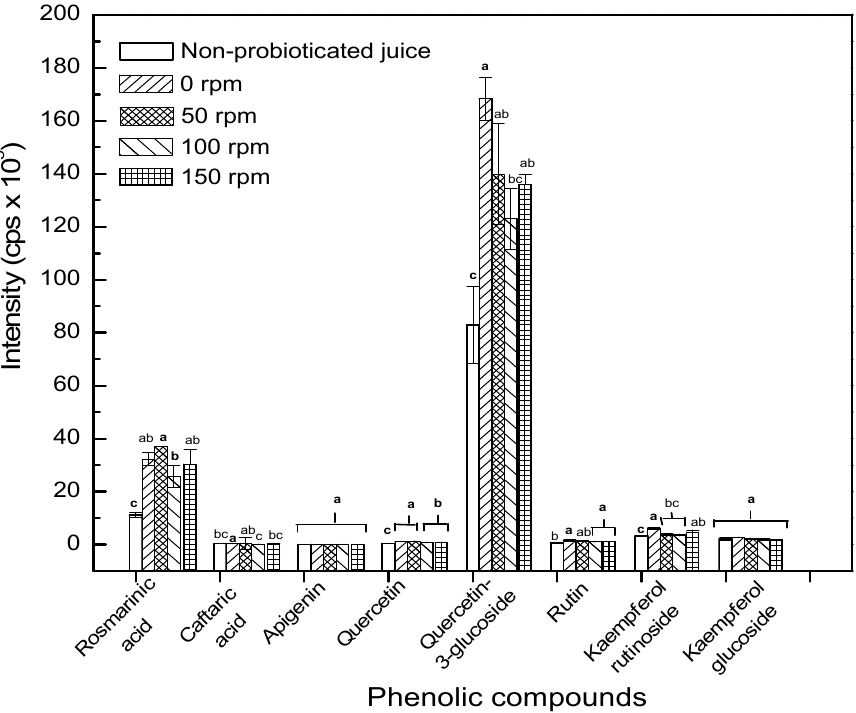
Figure 4. Intensity of target phenolic acids and flavonoids before and after 24-hour cultivation at di ff erent agitation speeds. Di ff erent letters of each compound indicate the significant di ff erent at p < 0.05.